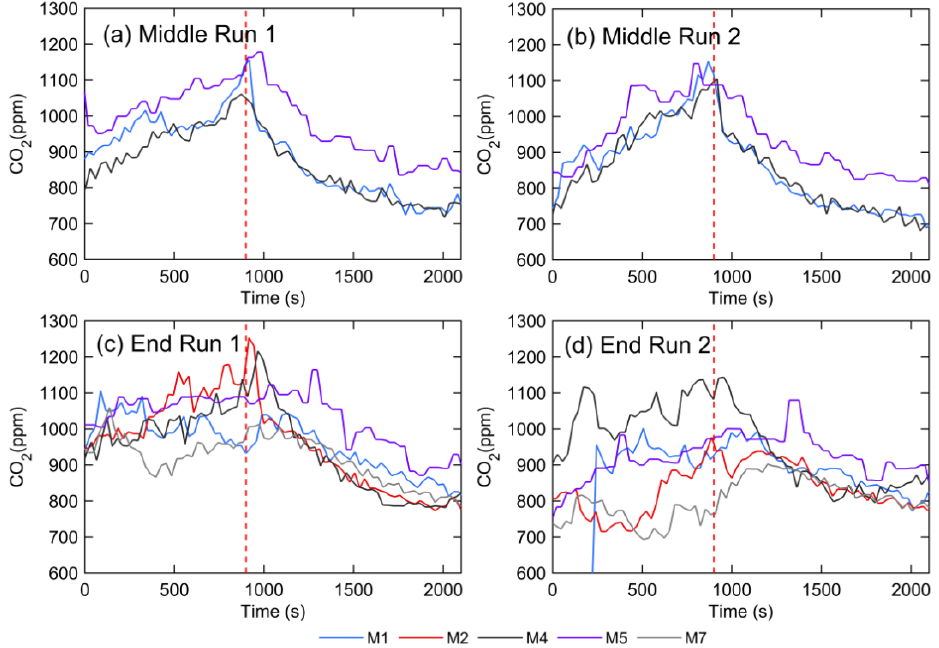
Figure 9. CO 2 concentrations for sensors placed at different heights for ( a ) middle run 1, ( b ) middle run 2, ( c ) end run 1 and ( d ) end run 2. Red dashed lines show time point at which ventilation is switched